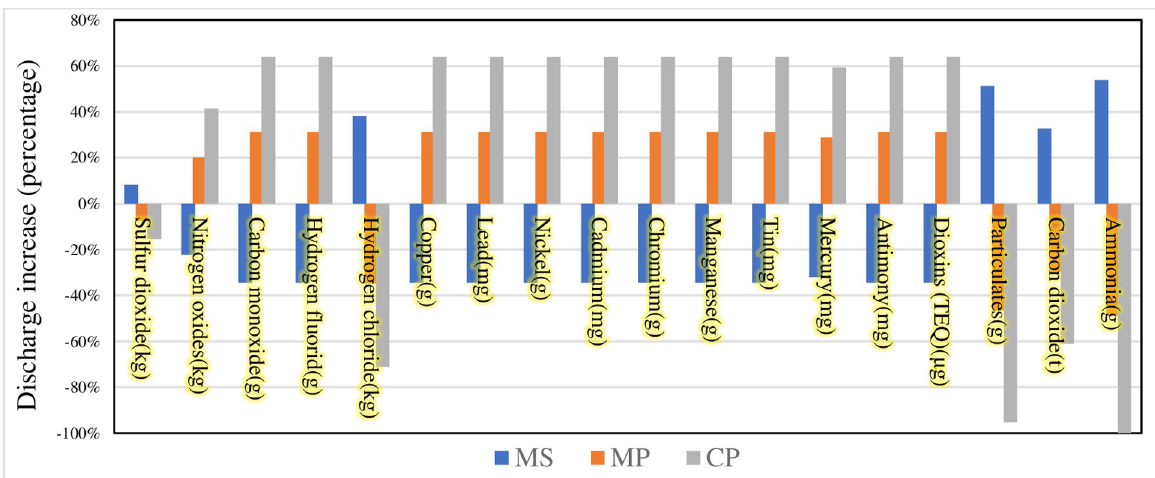
Fig 8. Bar plot showing the percentage increase in exhaust gas production compared to the BAU